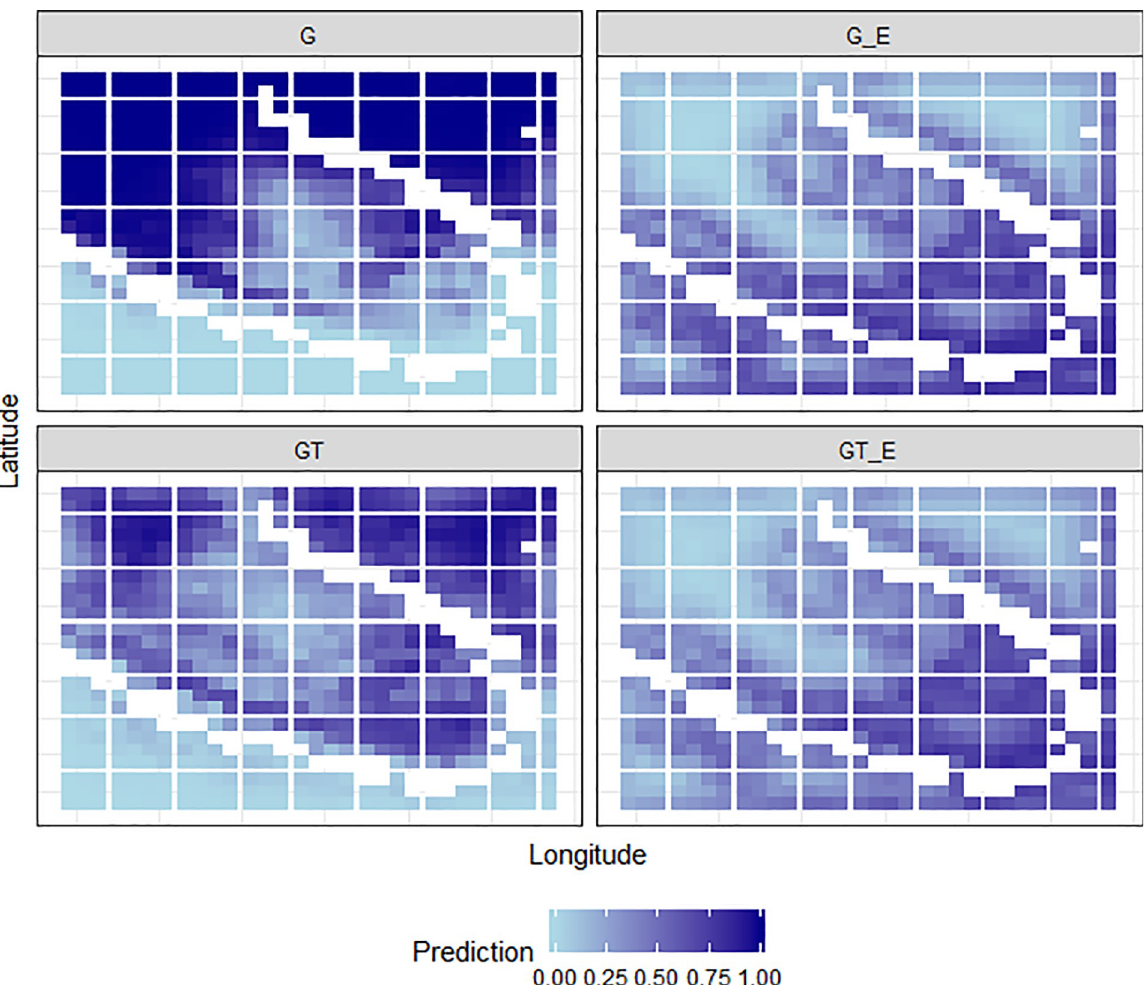
Fig 4. Model predictions. Probability of koala presence/absence in the study area as predicted by each model, shown on a continuous scale of 0 (absence, light blue) to 1 (presence, dark blue), with the Logan River shown in white. G = ground survey only, GT = ground and thermal-imagery surveys, G_E = combined ground-survey and expert-elicitation, GT_E = combined ground and thermal-imagery surveys and